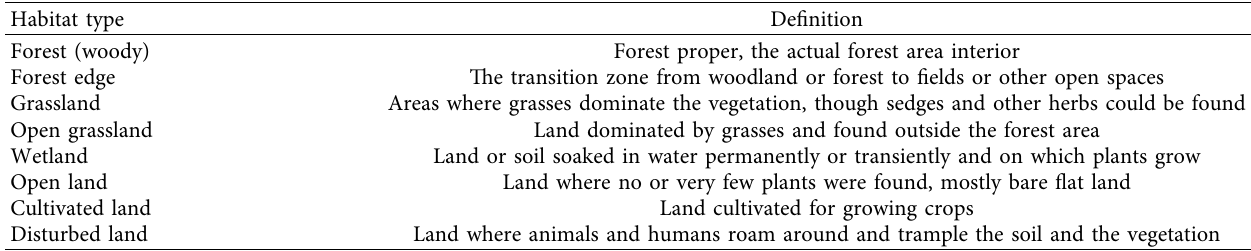
Table 2: Definition of